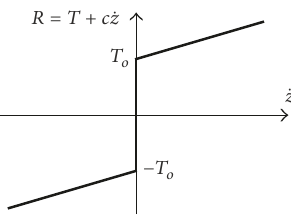
Figure5:Constitutiverelationshipofviscoplasticsystem(sliderand dashpot in parallel) (see Figure